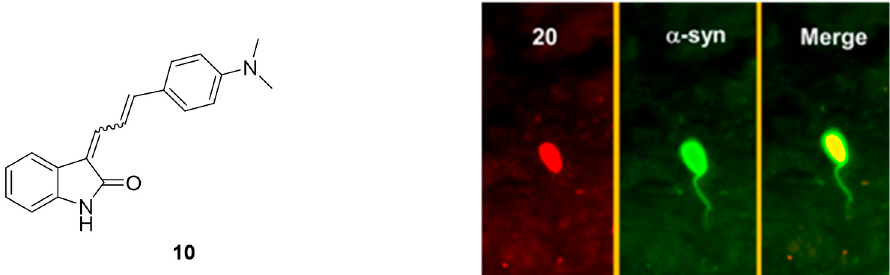
Figure 12. Chemical structure of 10 and fluorescent microscopy studies on brain tissue from PD/DLB and PD patients (reprinted with permission from [105] Copyright 2015 American Chemical Society).